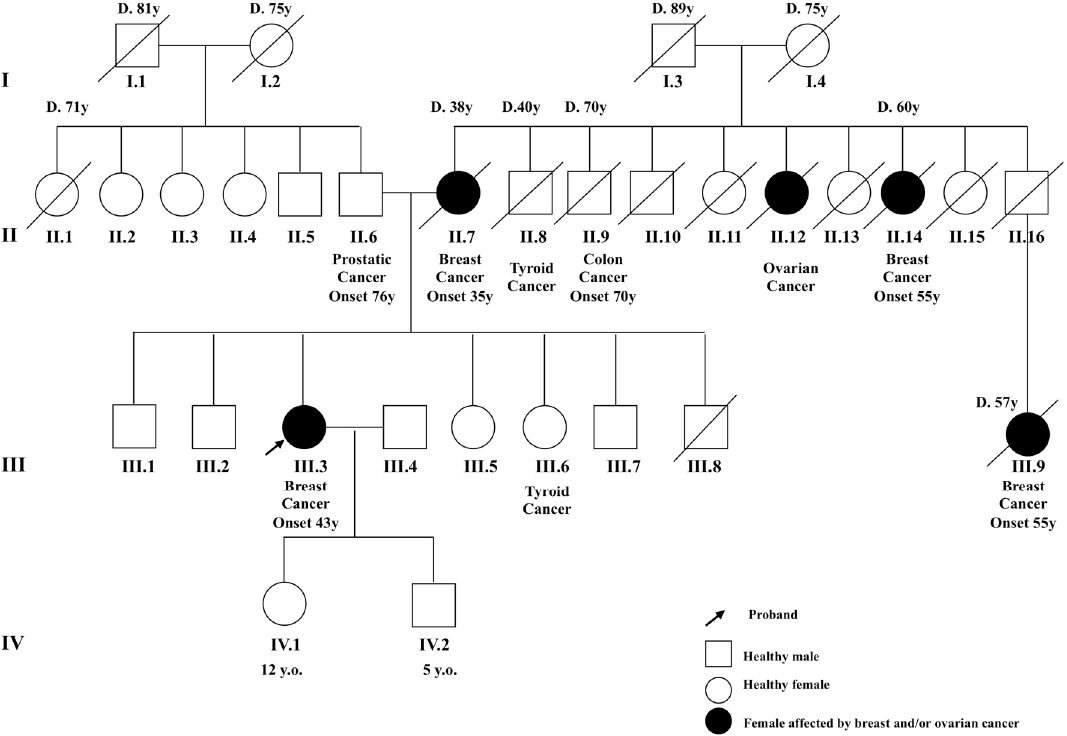
Figure 3. Pedigree of the patient. Our patient (III.3) is indicated by the arrow. Breast, ovarian, colon and prostate cancers are reported in the family. D.: age of death; y.o.: years old.